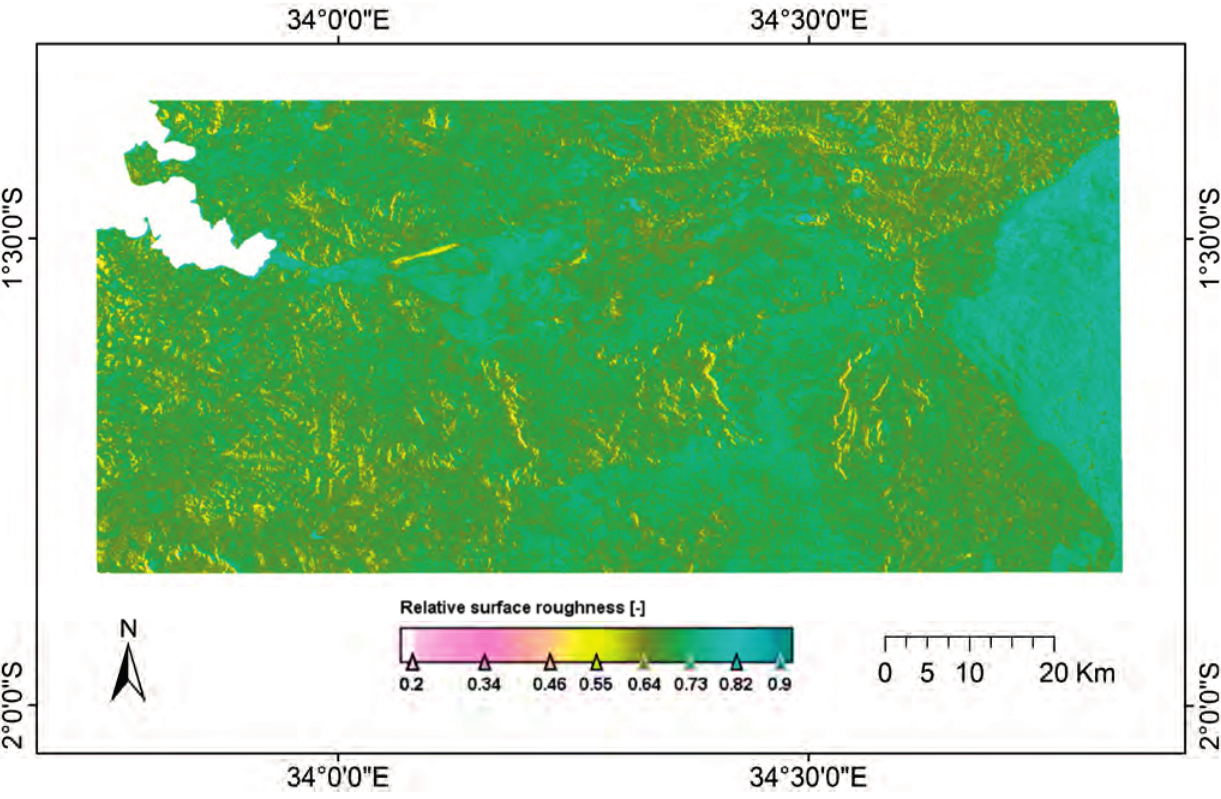
(cid:4667) of the study area on a scale of 0 to 1. (cid:3046)